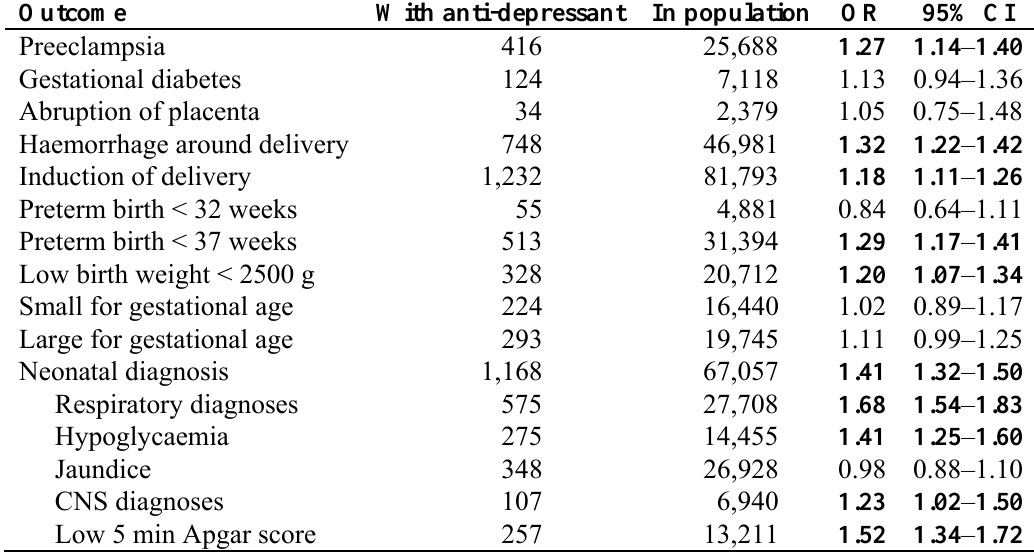
Table 36. Outcomes after maternal use of antidepressants during the 2nd or 3rd trimester. Bold text marks statistical